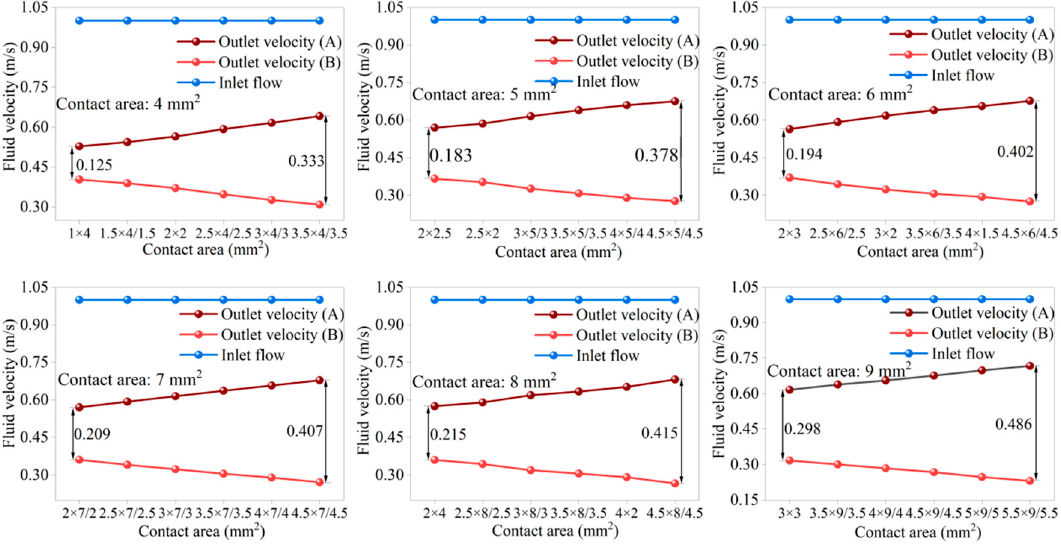
Figure 9. Variations in velocities at the outlets of the bifurcated fractures for a constant contact area. In Table 4, the velocity difference change is very small, about 0.29 m/s, indicating